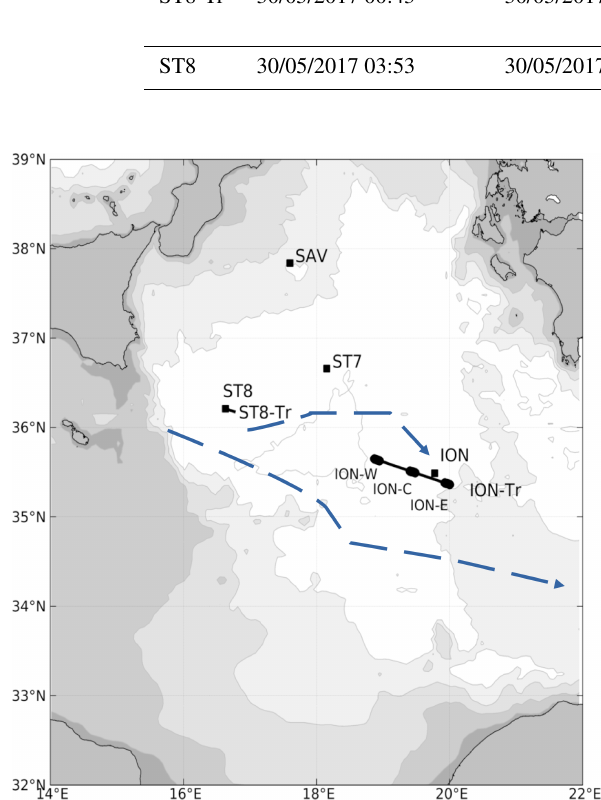
Figure 1. Bathymetry of the Ionian Sea (isobaths 100, 1000, 2000, 3000, 4000m) with the locations of stations (black squares), tran- sects and transect parts (black lines and dots). Schematic circulation (blue lines with arrows) for cyclonic conditions of the North Ionian Gyre redrawn from Menna et al. (2019). The blue dashed line indi- cates the average AW